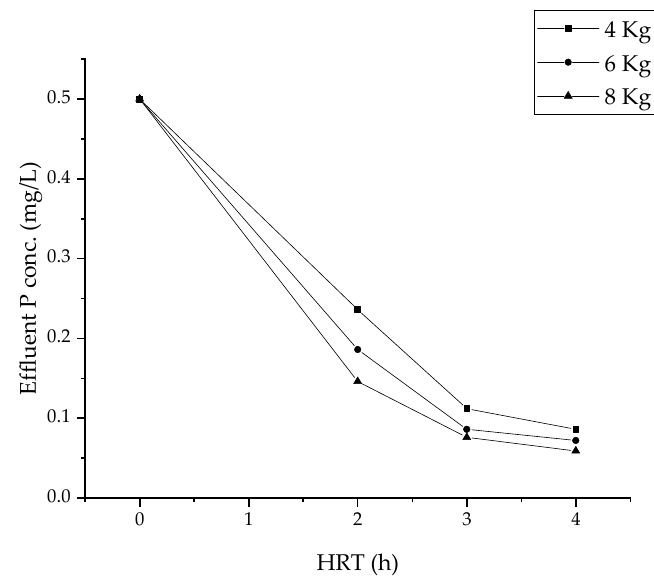
Figure 10. E ff ect of HRT in the reactor on the e ffl uent phosphorus Figure 10. Effect of HRT in the reactor on the effluent phosphorus concentration.